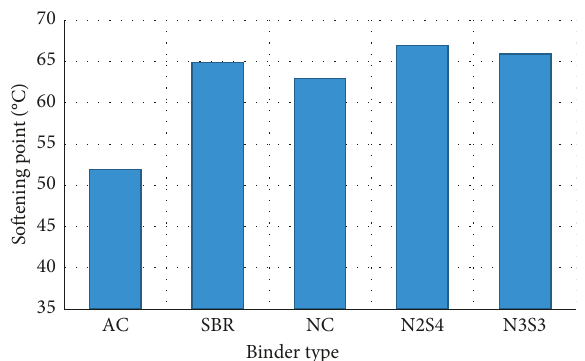
Binder Figure 3: Softening point test.